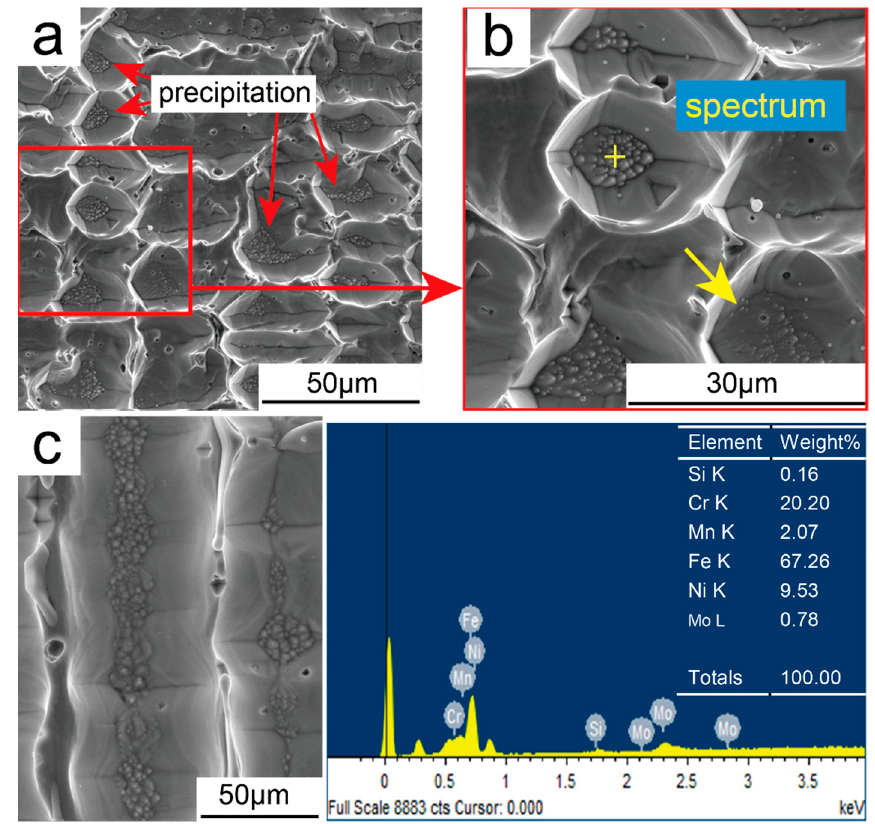
Figure 9. SEM micrograph of the as-deposited wall: ( a ) Precipitated phase in the middle region, ( b ) enlarged view of Figure 9a, and ( c ) precipitated phase along the columnar grain.